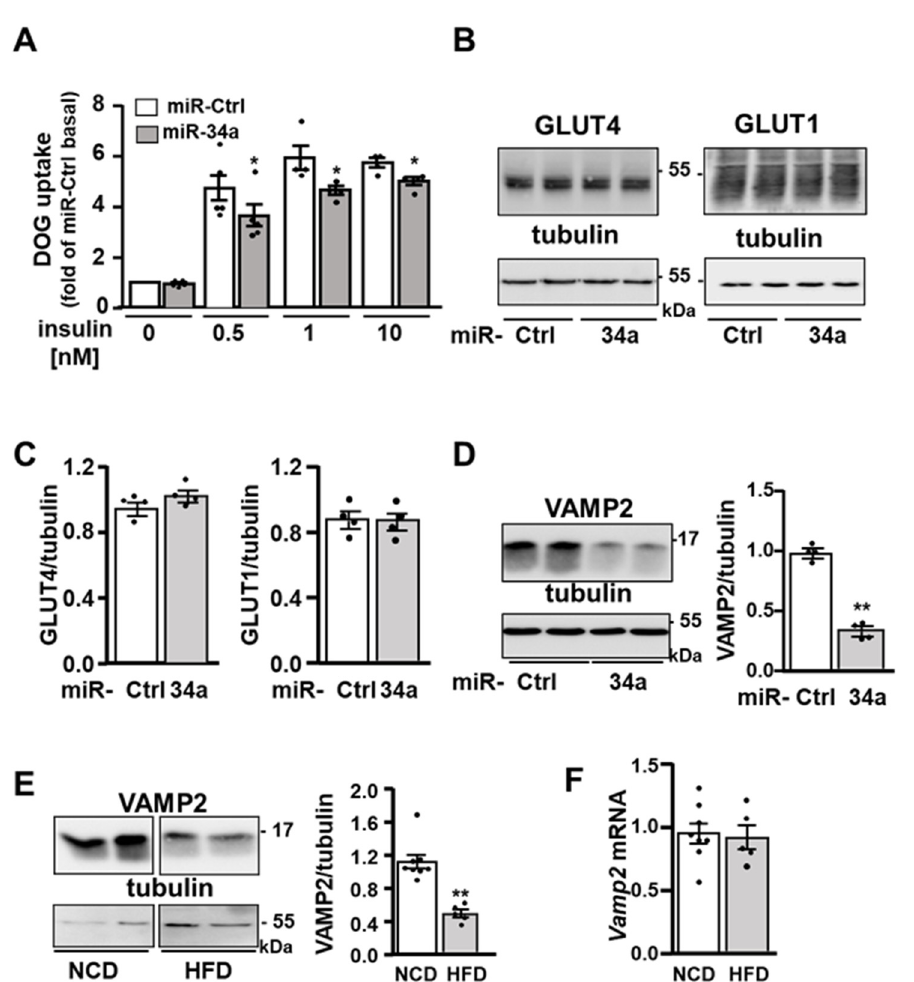
Figure 2. miR-34a overexpression inhibits insulin-induced glucose transport and reduces VAMP2 protein expression: ( A ) 2-deoxyglucose (DOG) uptake in 3T3-L1 adipocytes transfected with a control miRNA (miR-Ctrl) or miR-34a mimic and treated without or with the indicated concentration of insulin. Bar graph represents mean values ± SEM of four independent experiments. ( B ) Representative immunoblot ( left panel) of the expression of GLUT4 and GLUT1 with tubulin as loading control in 3T3-L1 adipocytes transfected with a control miRNA (miR-Ctrl) or miR-34a mimic. ( C ) Bar graph represents the densitometry analysis for the GLUT4 or GLUT1/tubulin ratio from four independent experiments. ( D ) Representative immunoblot ( left panel) of the expression of VAMP2 with tubulin as loading control in 3T3-L1 adipocytes transfected as in ( B ). Bar graph ( right panel) represents the densitometry analysis for the VAMP2/tubulin ratio from four independent experiments. ( E ) Representative immunoblot ( left panel) of the expression of VAMP2 with tubulin as loading control in eAT of mice fed with a normal chow diet (NCD) or a high-fat diet (HFD) for 13 weeks. Bar graph ( right panel) represents the densitometry analysis for the VAMP2/tubulin ratio in eAT of n = 5–8 mice/group. ( F ) Relative level of Vamp2 mRNA in eAT of mice fed with a NCD or HFD for 13 weeks ( n = 5–8 mice/group). Relative level of Vamp2 mRNA was normalized to Rplp0 ( 36B4 ). Bar graphs are mean values ± SEM. * p < 0.05 and ** p <